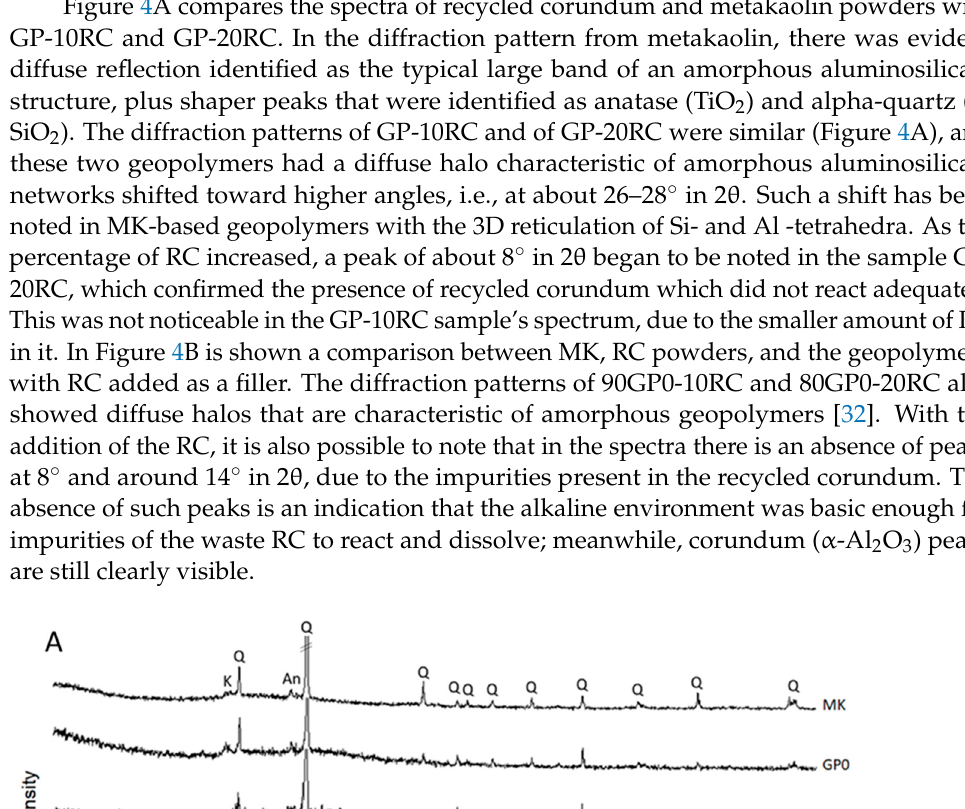
Figure 4. ( A ) XRD patterns for RC raw materials MK, GP-10RC, and GP-20RC recycled corundum- based geopolymers. ( B ) XRD patterns for RC raw materials MK, 90GP0-10RC, and 80GP0-20RC. Crystalline phases identification labels: Q = alpha-quartz (01-083-0539), K = kaolinite (01-075-0938), C=corundum (01-071-1124) An = anatase (01-071-1167), M: montmorillonite (00-012-0232), V: valleriite (01-073-0516). 3.5. Microstructural SEM Observation As shown in Figure 5A, the microstructure of waste corundum grains was observed to be prismatic in shape, with sizes in the range of 50 – 500 µm. Figure 5B shows a finer powdery deposit at the surface of the corundum grains that can be attributed either to finer Al 2 O 3 particles, or to contaminants from the erosion operation. As far as the chemical composition of the waste is concerned (Figure 5C), it appeared rich in oxygen (O) (52 ± 6 wt%), aluminium (Al) (32 ± 5wt%), with a good approximation to an Al/O atomic ratio equal to 0.62 (with respect to a 0.67 theoretical ratio); this indicated that there was a high content of Al 2 O 3 , with a relatively low content of contaminants deriving from the erosion testing. In particular, we recorded sodium (Na) (1.62 wt%), nitrogen, Ti, Fe, Ti, Fe, and Si, consistent with the crystalline impurities of aluminosilicates found from XRD diffraction (Figure 4A,B). The presence of considerable contents of carbon (8.55 wt%) was due to the presence of carbon adhesive tape that was used for sample preparation.